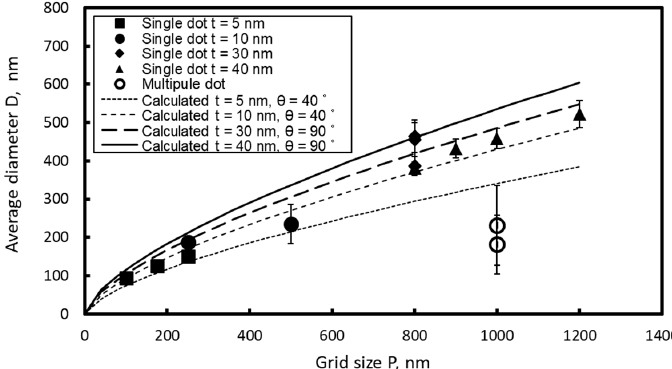
Figure 4. Variation of average nanodot size and its standard deviation against grid size.